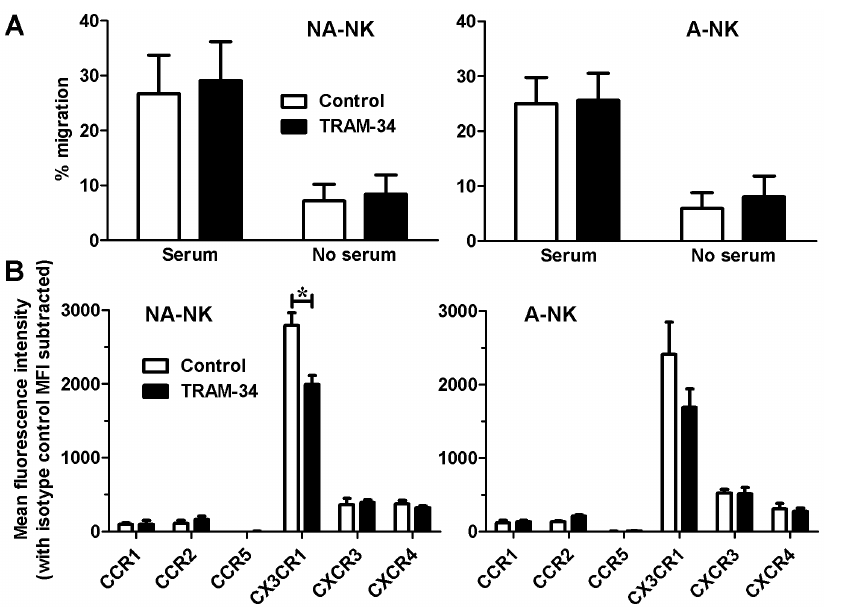
Figure 8. Blocking KCa3.1 affects the expression levels of CX3CR1 but not of other chemokine receptors or NK cell migration. A: Effect of 1 m M TRAM-34 (black) and vehicle (white) on the migration of NA-NK (left) and A-NK (right) cells in the presence and absence of serum. Data represent the mean 6 SEM of data obtained with cells from 6 donors. B: Effect of 1 m M TRAM-34 (black) and vehicle (right) on the expression levels of chemokine receptors by NA-NK (left) and A-NK (right) cells. Data represent the mean fluorescence intensity with anti-chemokine receptor antibodies after subtracting the background mean fluorescence intensity in the presence of isotype control. N=3 donors. *p , 0.05. doi:10.1371/journal.pone.0076740.g008 characteristic property of the Kv1.3 channel, which needs 30 sec (Fig. 1A, pulse # 1). Rapid pulsing every second reduced current to go from the inactivated to the closed conformation following amplitude at every pulse in a ‘‘use-dependent’’ manner, a 200 ms pulses (Fig. 1A). Pulsing the cells to 2 60 mV was not